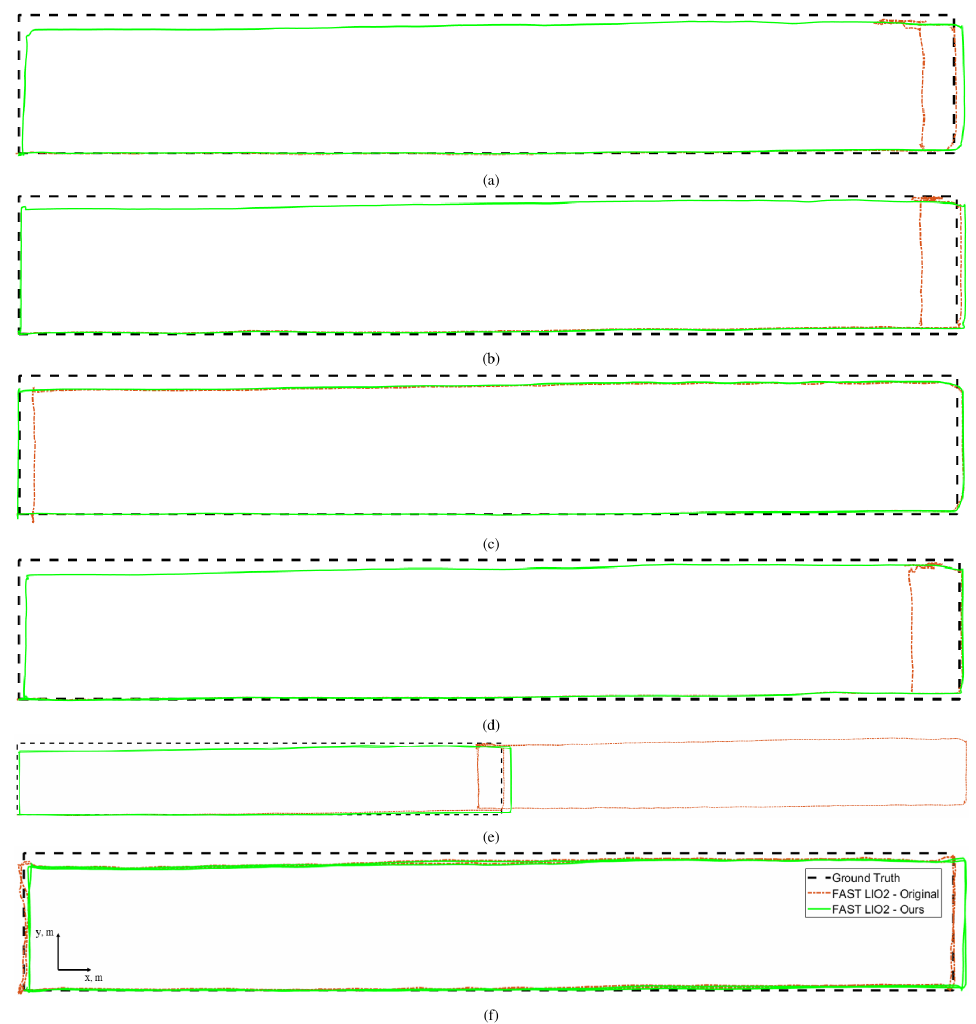
Figure 6. Estimated trajectory path comparison between the original and improved FAST-LIO2 in a flat terrain section of the tunnel environment: ( a – d ) single-loop runs, and ( e , f ) double-loop runs. When comparing the generated paths in the inclined section with those in the flat section, we can observe that the performance of the original FAST-LIO2 is much worse in the inclined section (no generated path is close to the ground truth). The estimated trajectory is relatively good only in the y global direction. In contrast, our modified FAST- LIO2 algorithm generates paths that are close to the ground truth in all six experiment runs. Moreover, the elevation information of the trajectory is estimated well. Compared to the ATE results, the RTE results show a better understanding of the trajectory error throughout the whole paths. Specifically, from the estimated trajectories in Figure 8d,e we can see that the original FAST-LIO2 algorithm outputs a lower trajectory error in the latter part of the trajectory run compared to that of the other